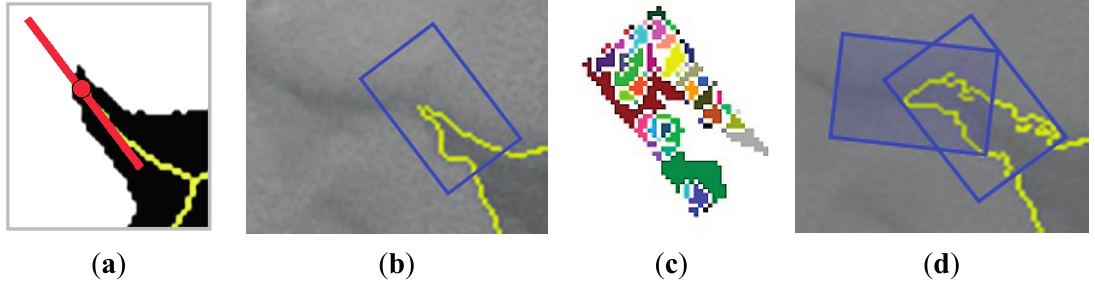
Figure 7. Add Growing process: ( a ) Growing point and direction; ( b ) growing window; ( c ) watershed regions and; ( d ) new structure after the application of watershed and region growing and subsequent growing